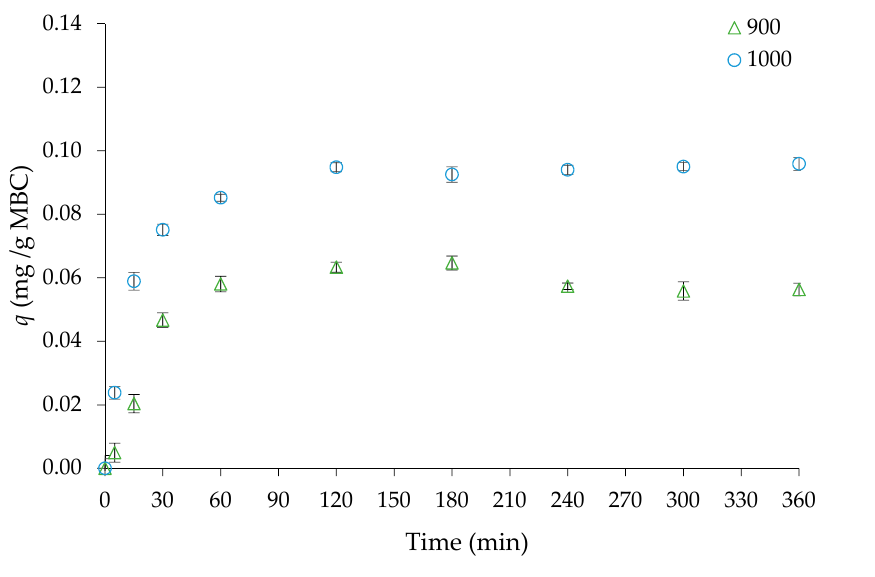
Figure 3. Nitrate removal with kinetic experiments for MBC prepared at 900 °C and 1000 °C. Table 1. Adsorption kinetic models for nitrate removal with MBC prepared at 1000